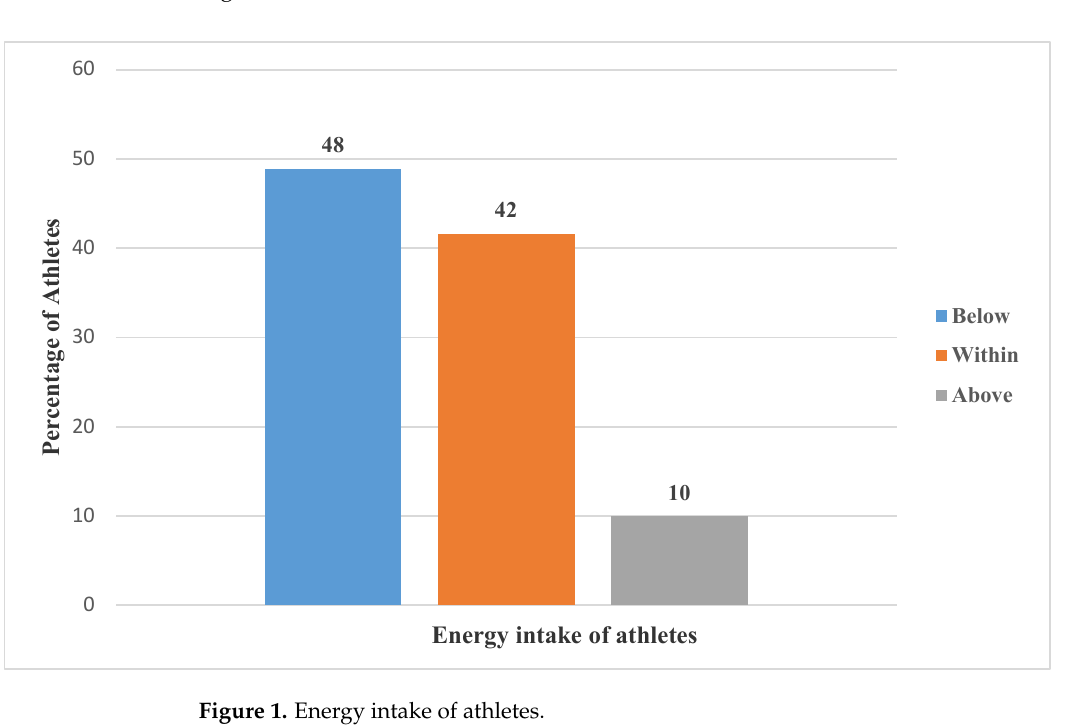
Figure 1. Energy intake of athletes.